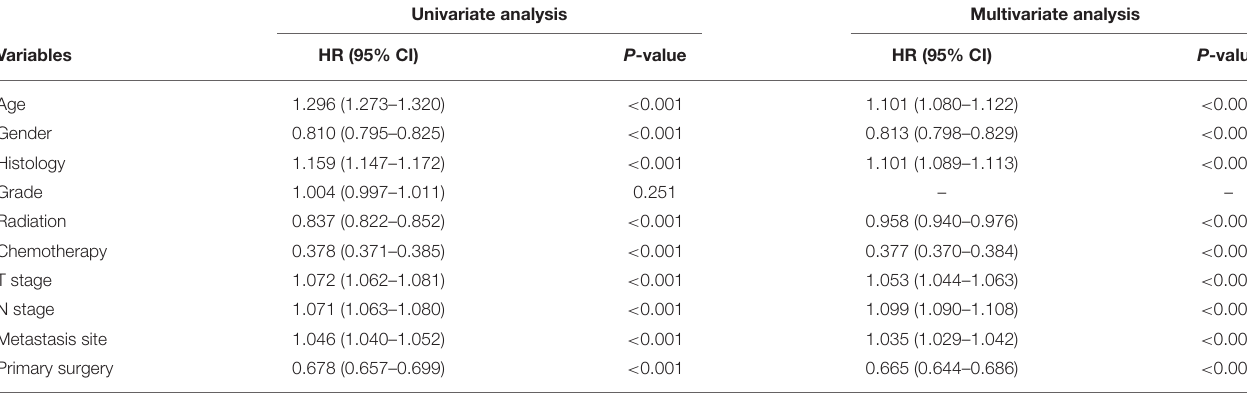
TABLE 3 | Univariate and multivariate analysis of clinicopathological characteristics for OS of all patients. Univariate analysis Multivariate analysis